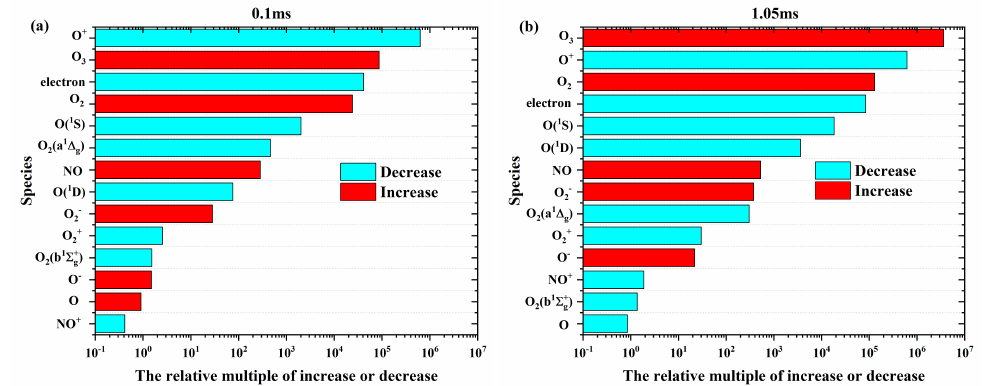
Figure 11. The changes in species density at times ( a ) 0.1 ms and ( b ) 1.05 ms compared with the highly ionized stage.